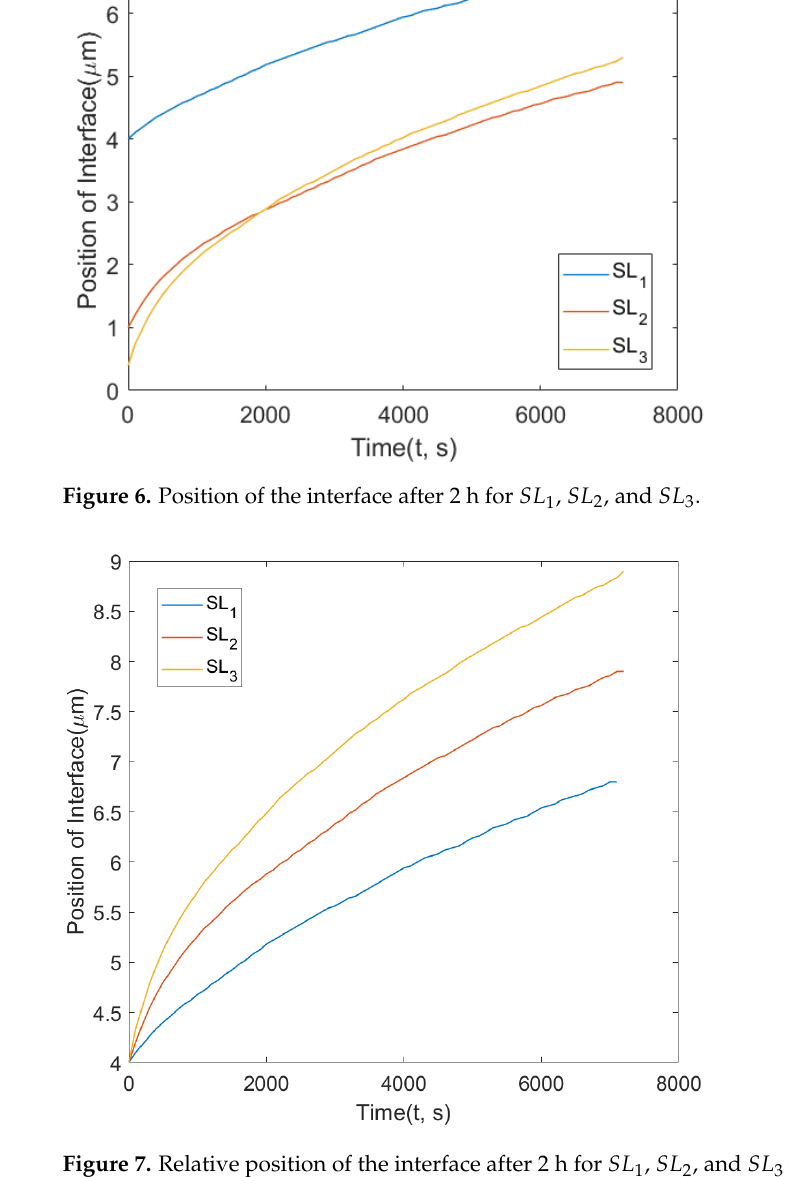
Figure 7. Relative position of the interface after 2 h for SL 1 , SL 2 , and SL 3 when the starting point is adjusted for SL 2 and SL 3 so that it is same for all three cases, i.e., 4 µ m. A clear difference is observed when SL 3 moved further than Sl 2 and SL 1